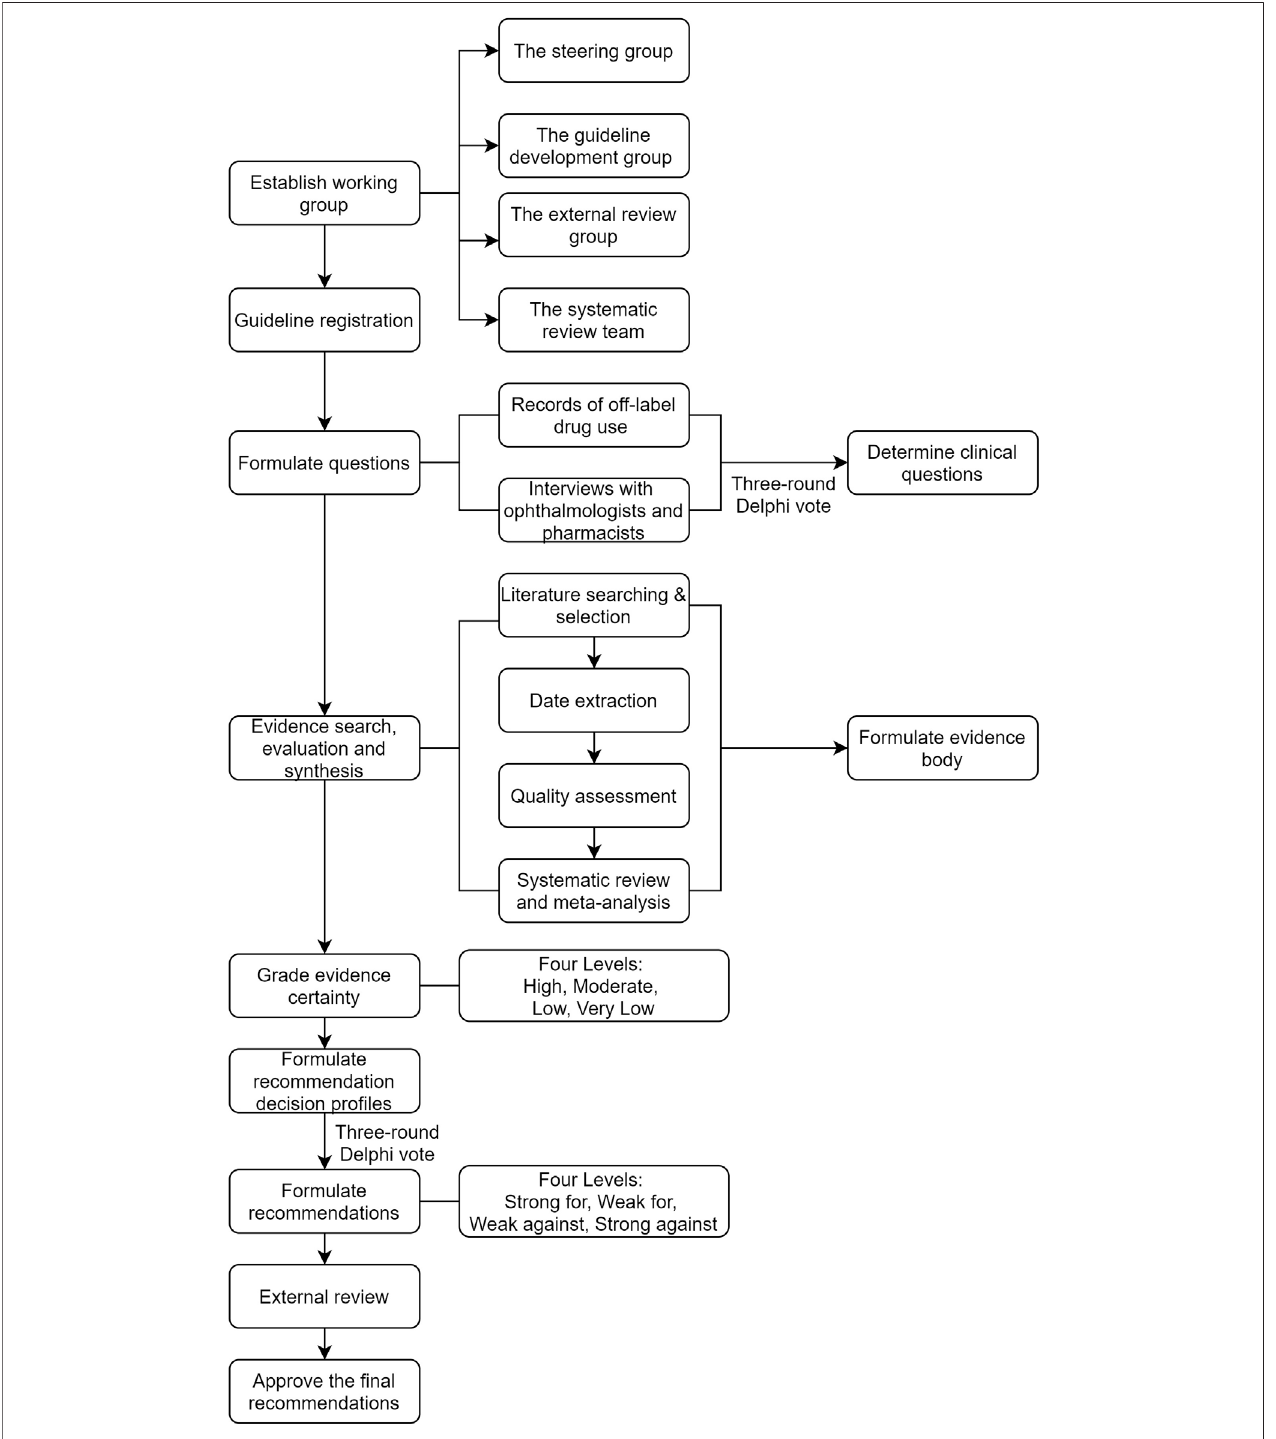
FIGURE 1 | The fl owchart of the guideline development